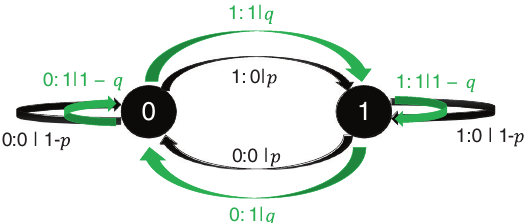
Fig. 2 ε -transducer for the actively perturbed coin. Here, node 0 (1) is identi fi ed with causal state s 0 ( s 1 ) and represents pasts where the last coin toss resulted in tails (heads). Each non-zero transition element T kjy | x is then represented by a directed edge from node k to j labeled by ‘ y | x : T kjy | x ’ . Here, future statistics can be generated by transition elements T 011 | 0 = T 100 | 0 = p , T 000 | 0 = T 111 | 0 = 1 − p , T 100 | 1